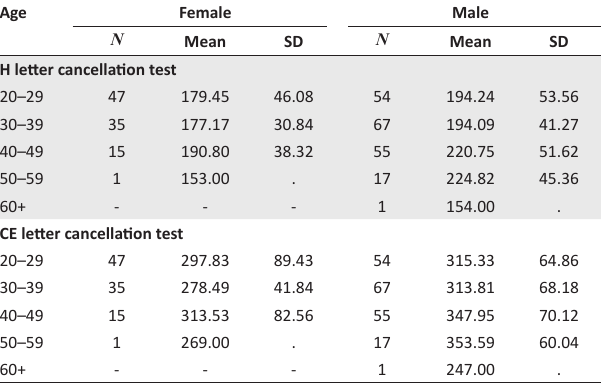
TABLE 7: Descriptive statistics for total time for gender by age.